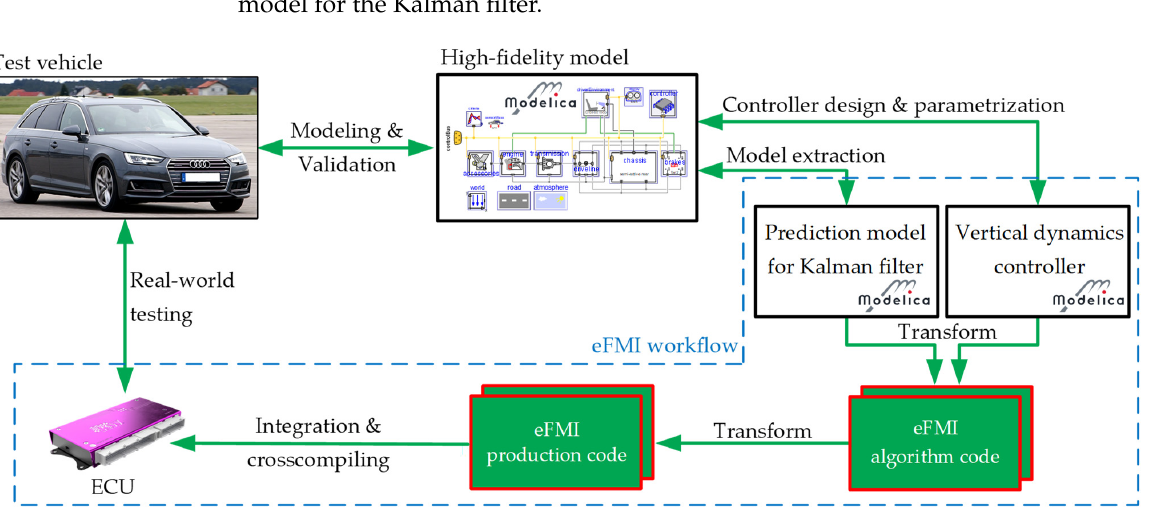
Figure 3. The vertical dynamics controller and prediction model design process using the eFMI workflow (adapted from [14]).